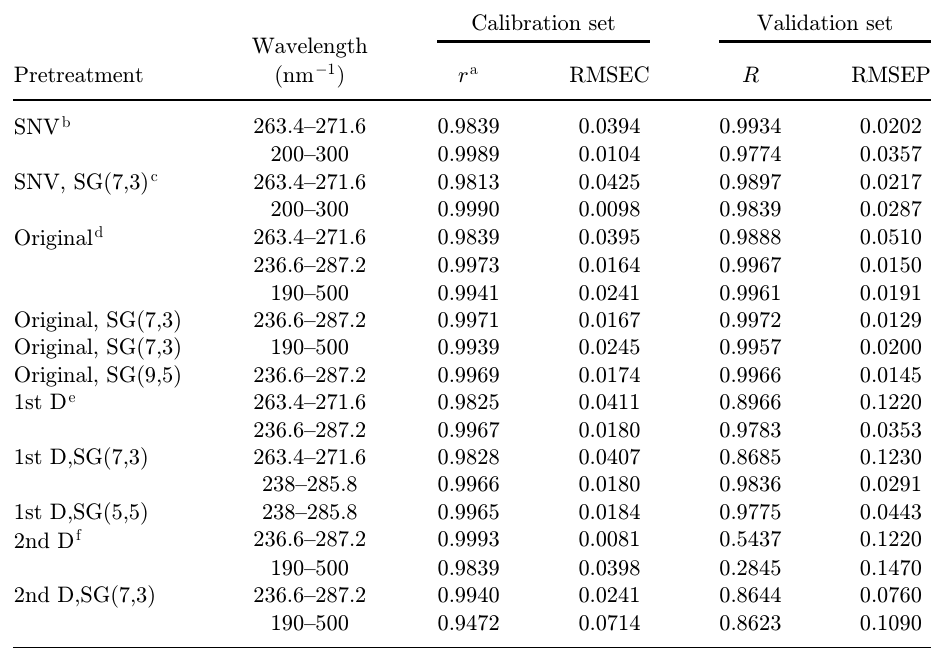
Table 1. The results of pretreatment of the spectral data by some methods.